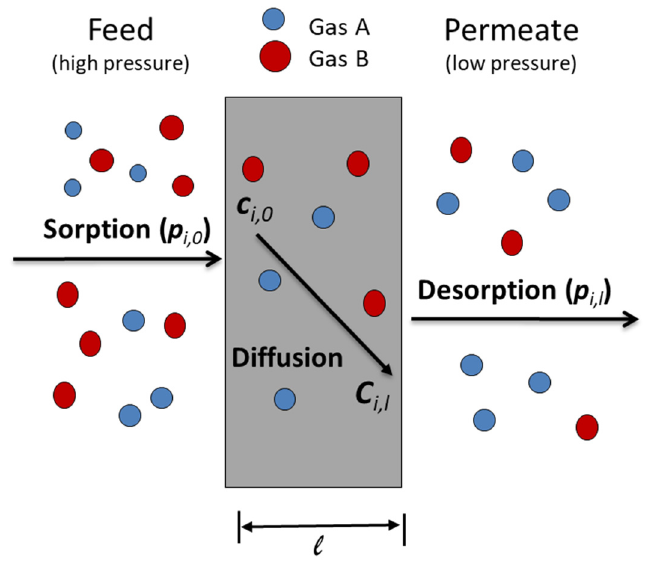
Figure 4. Detailed overview of mass transfer by solution-diffusion model.